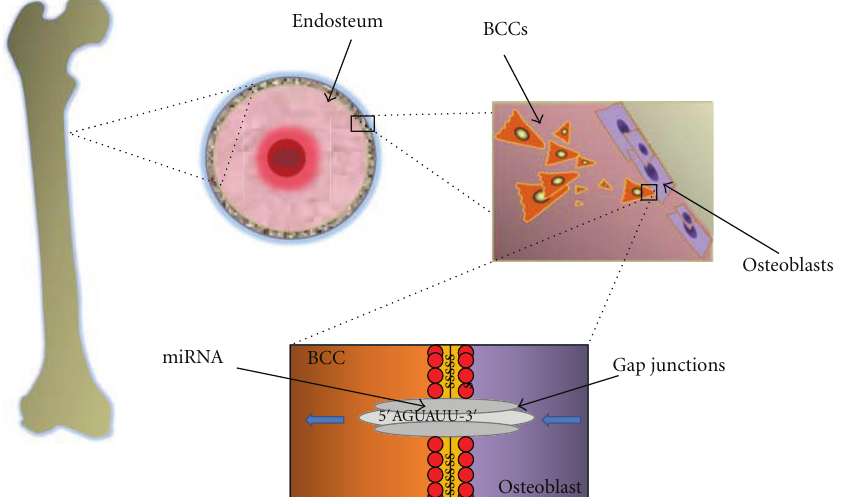
Figure 2: Stromal cells in the endosteal region of the bone marrow produce the chemokine, CXCL12, a known regulator in hematopoiesis. Through an interaction between CXCL12 and CXCR4 (a receptor on the BCC), malignant cells are drawn from circulation to the stromal niche. There, BCCs may form gap junctions with osteoblasts, which facilitates the intercellular transfer of small molecules such as miRNAs. Experimental evidence demonstrates that micro-RNAs can traverse gap junctions and induce dormancy of